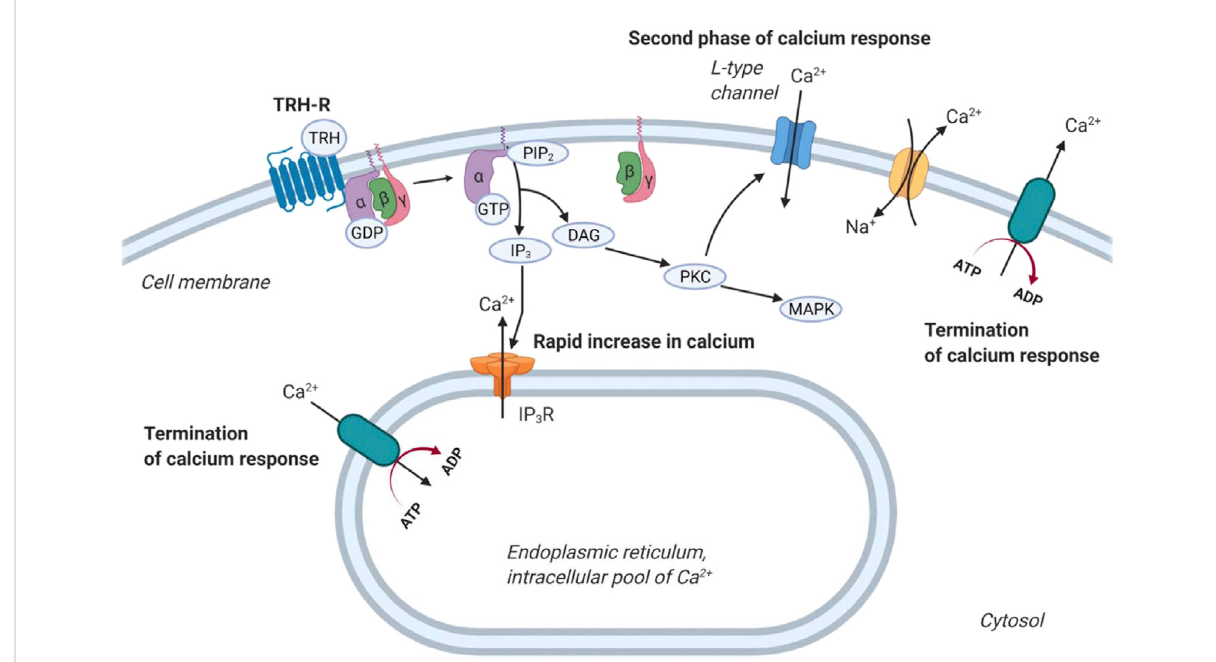
FIGURE 3 Regulation of calcium release by TRHreceptor. At fi rst, TRH acting through the G protein coupled TRH-R activates the cleavage of PIP 2 into IP 3 and DAG.